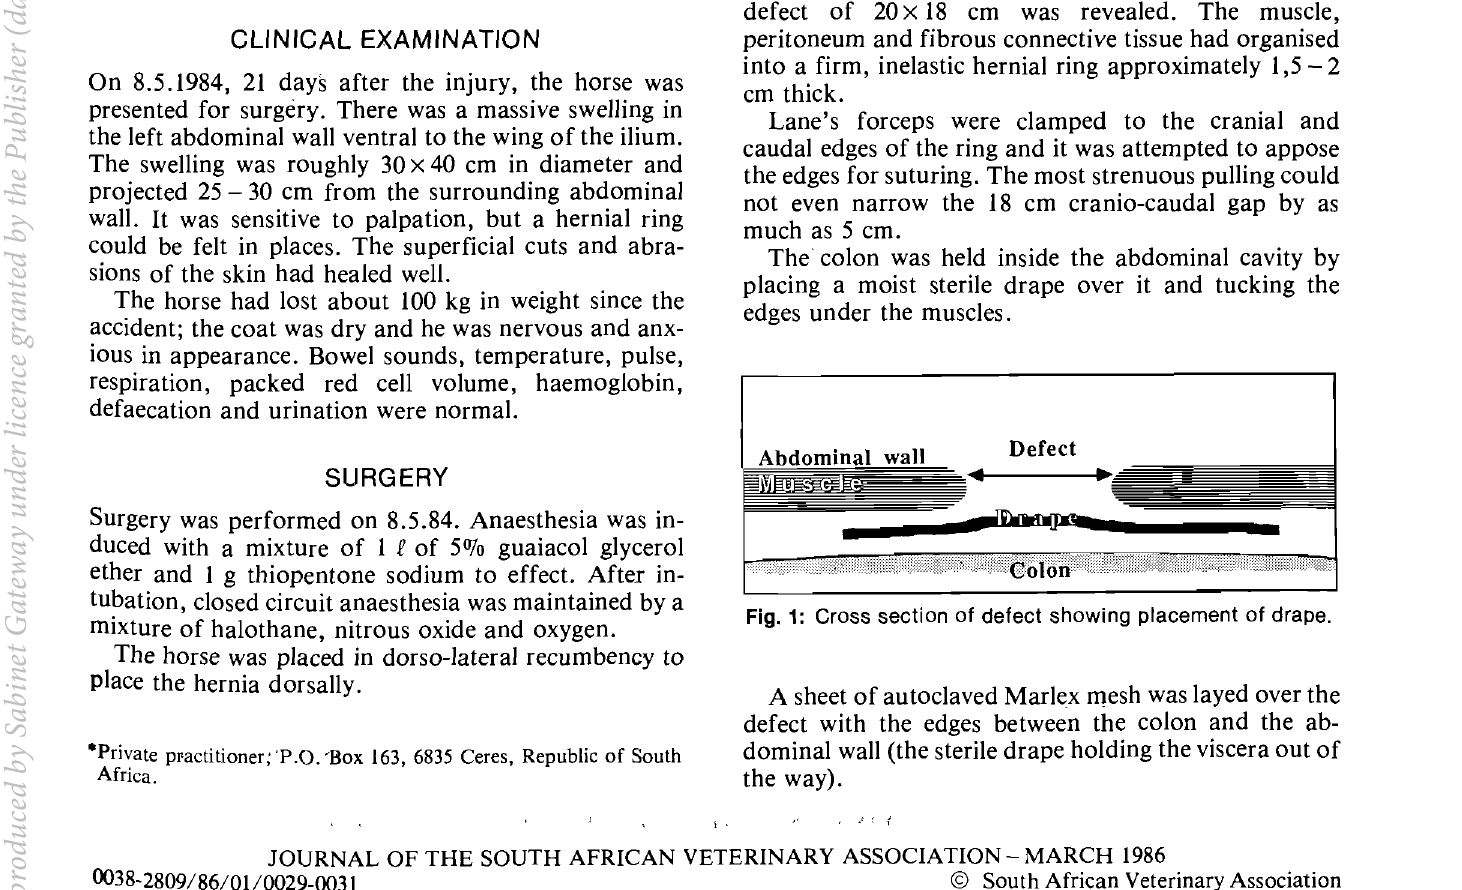
A sheet of autoclaved Marlex mesh was layed over the defect with the edges between the colon and the ab dominal wall (the sterile drape holding the viscera out of the